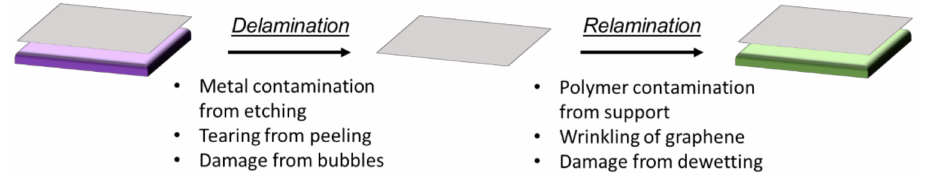
Figure 1. Pictorial representation of the two main stages of the graphene transfer process, delamination and relamination, accompanied by examples of issues that arise during each stage that can lead to degradation of graphene’s